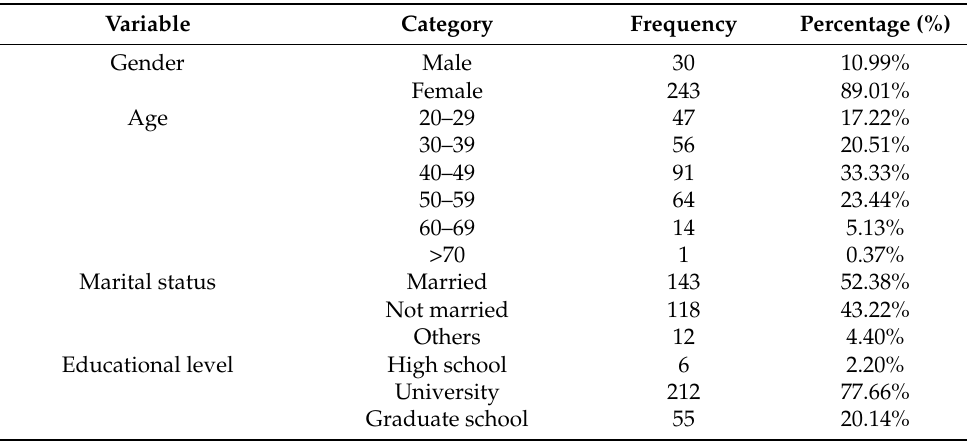
Table 1. Respondents’ demographic